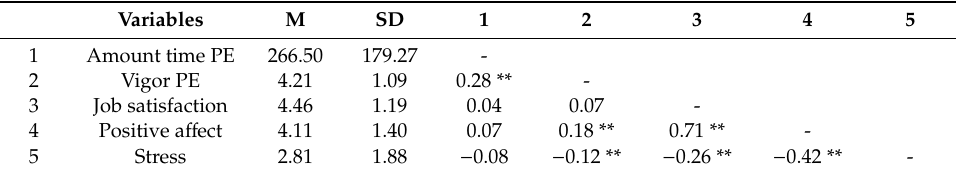
Table 1. Descriptive statistics and correlations between the study